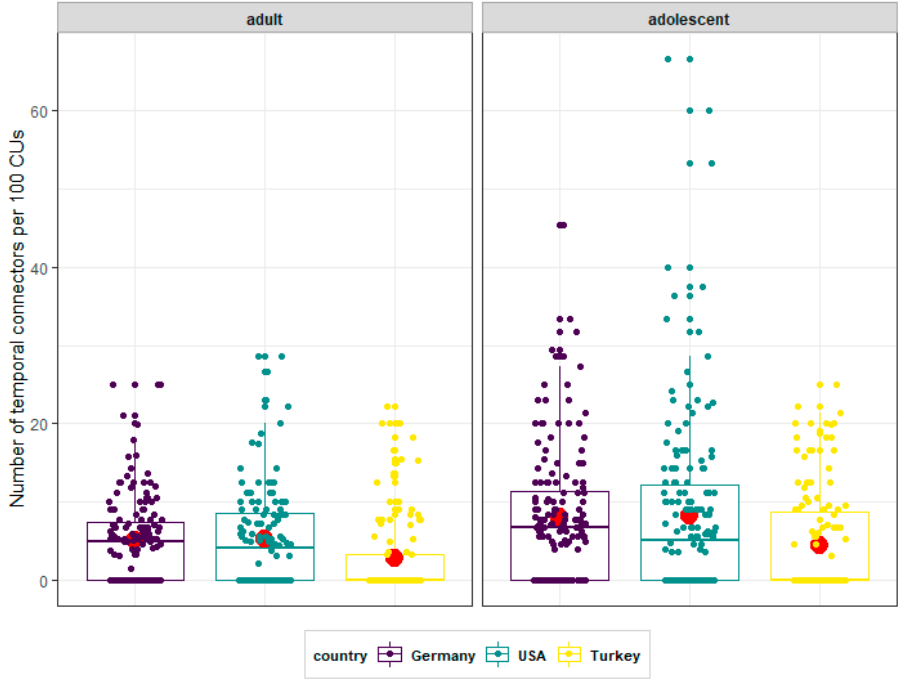
Figure 6. Box plots for individual participants’ number of temporal connectors per 100